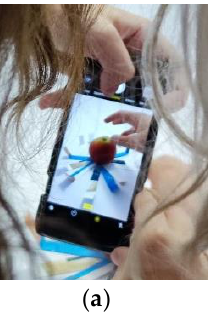
Figure 4. The second attempt using a Light Box. An artificially simulated background was placed around the object ( a ) Original view; ( b ) Additional environment; ( c ) Effects, ( d ) Final view.